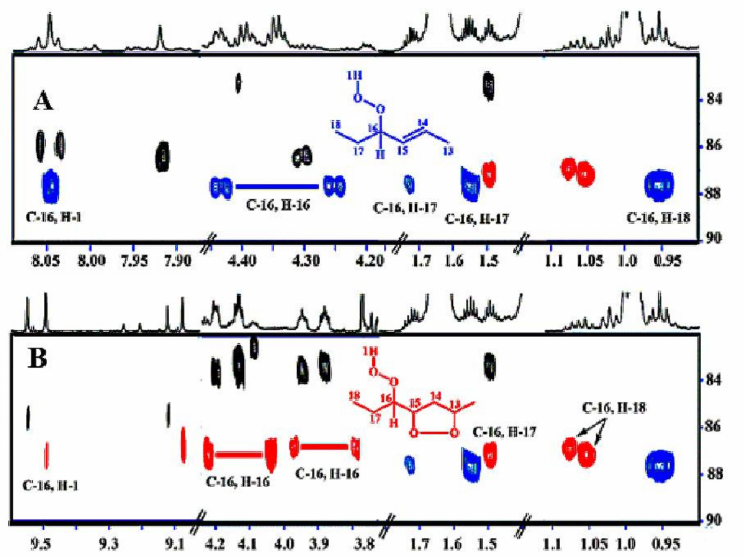
Figure 44. Selected regions of 800 MHz 1 H- 13 C HMBC NMR spectrum of 20 mg methyl linolenate in CDCl 3 , subjected to heating at 40 ◦ C for 48 h. Number of scans = 32, number of increments = 256, total experimental time = 12 h, T = 298 K. The critical cross-peak connectivities of C-16 with H-1(OOH), H-16 ( 1 J ( 13 C, 1 H)), H-17, and H-18 of the 9- cis , 12- cis , 14- trans -16-OOH hydroperoxide ( A ), and two diastereomeric 9- cis , 11- trans -16-OOH endo -hydroperoxides (in red) ( B ), are illustrated